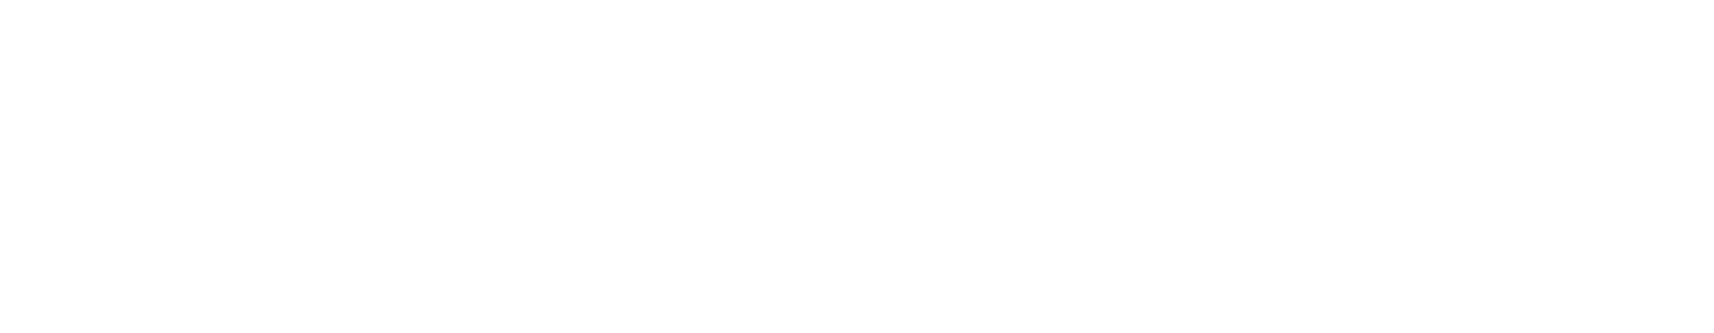
Table 5 Factors securing the first five rank in different